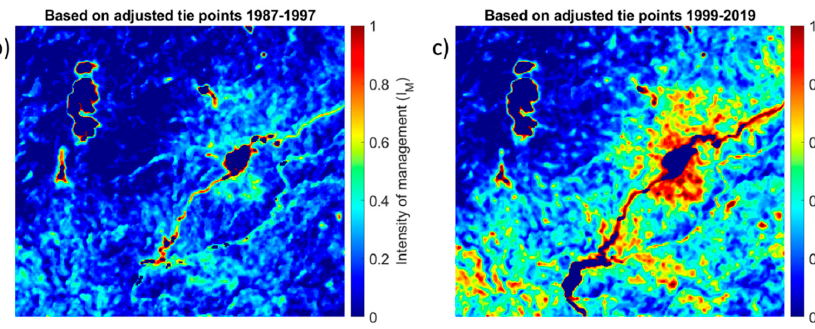
Figure 12. ( a ) Adjusted tie-points for NF ( T N ) and HMCF ( T H ), and the intensity of management ( I m ) estimated using the new tie-points for ( b ) the 1987–1997 and ( c ) 1999–2019 periods. In ( a ), for